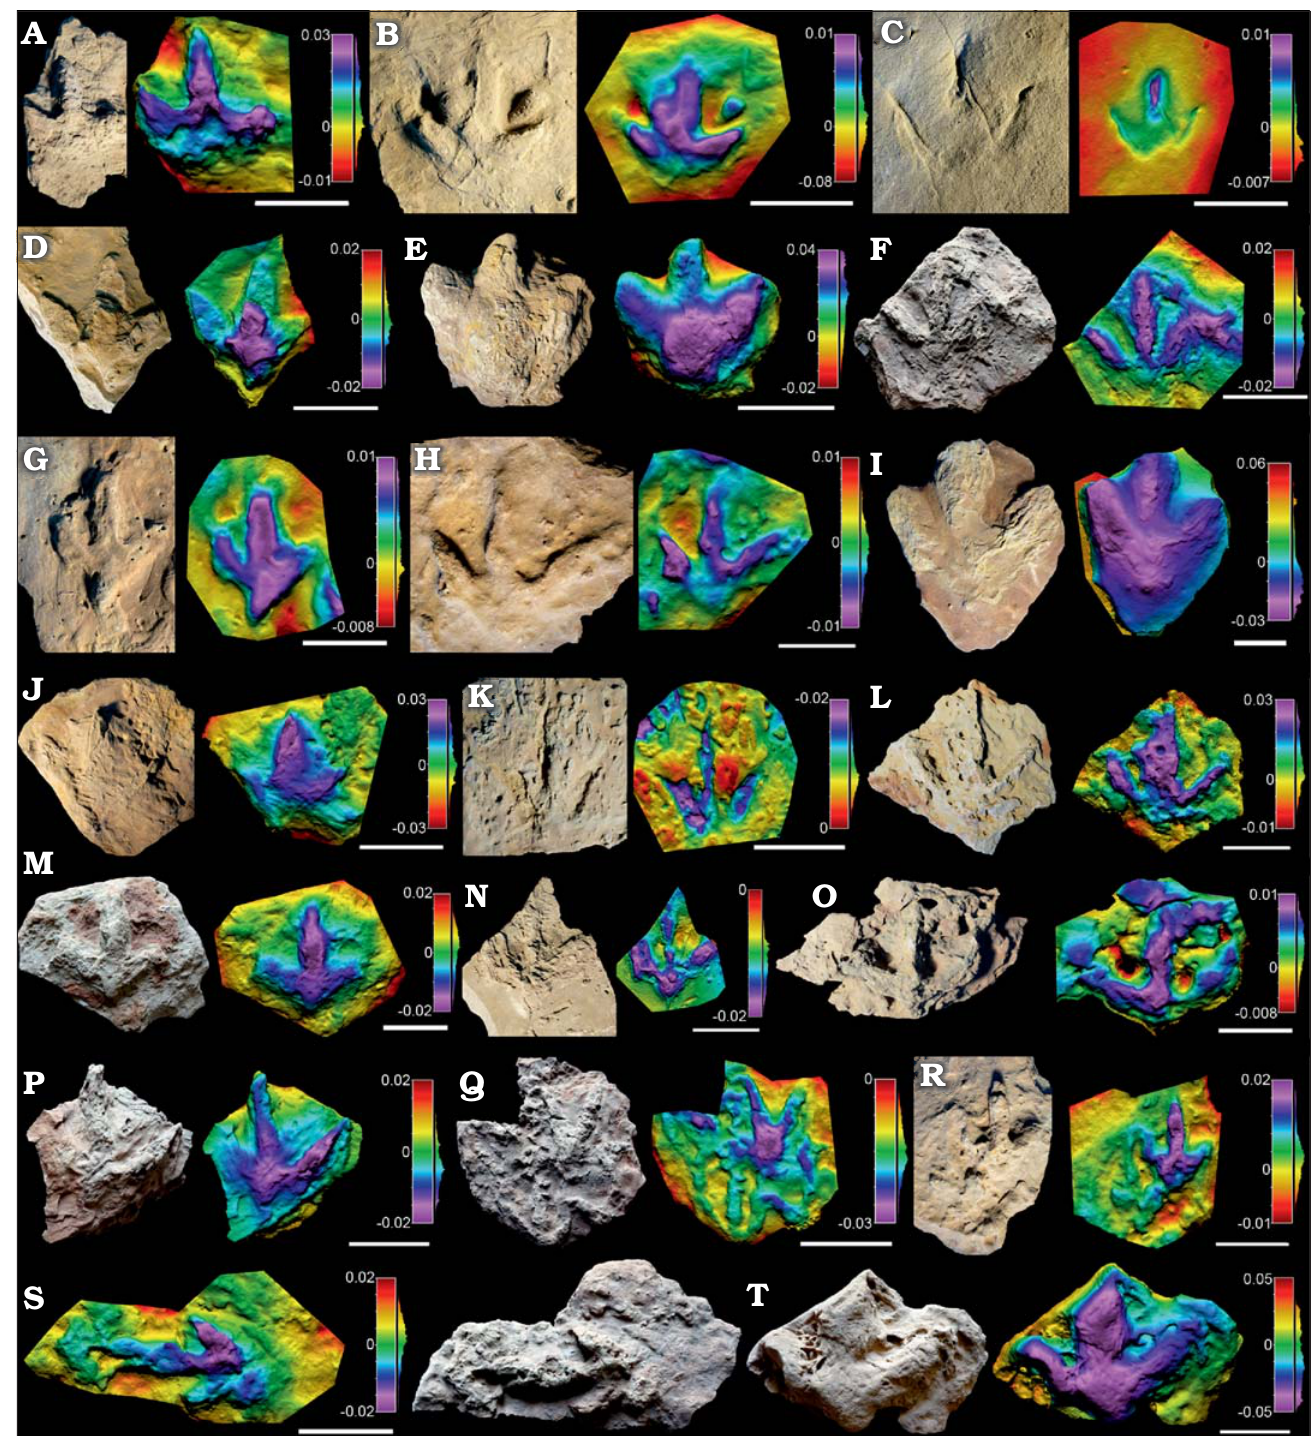
Fig. 6. Photographs, false-colour depth maps of the tracks of low morphological quality (MP < 2) of Ornithopoda indet. tracks, Portugal, Praia de Amoreira- Porto Novo Formation, upper Kimmeridgian (A–D), ?Sobral Formation, upper Kimmeridgian–lower Tithonian (E), Alcobaça Formation, Kimmeridgian– lower Tithonian (?F, G–T) A . SHN.(JJS).ICNO.11, Foz Arelho. B . SHN.(JJS).ICNO.43, Praia da Vermelha. C . SHN.(JJS).ICNO.46, Foz Arelho. D .